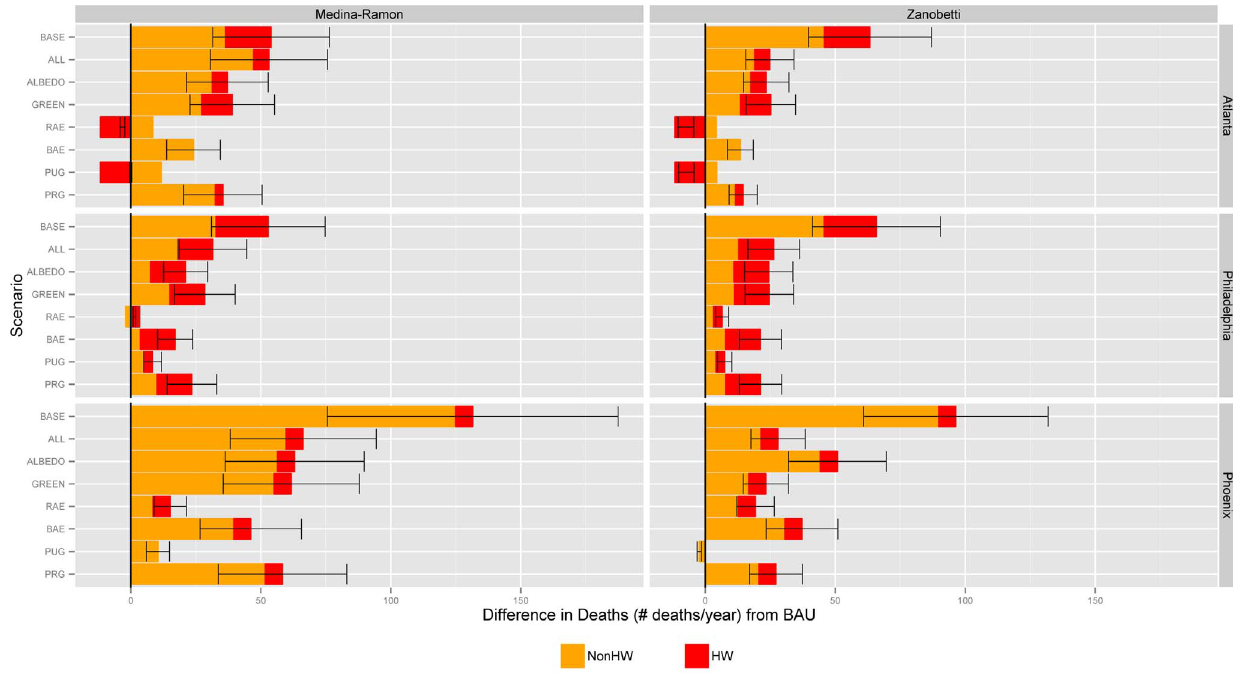
Figure 4. Difference in mortality relative to BAU by heat management scenario, HRF, and MSA. Bars report estimated difference in mortality relative to BAU in response to either the Medina-Ramon minimum temperature (minT) or Zanobetti average apparent temperature (avgapT) HRFs (orange shading) combined with the Anderson average temperature (avgT) HRF for heat wave conditions (red shading). Positive results denote a reduction in mortality relative to the BAU scenario; negative results denote an increase in mortality relative to the BAU scenario. Error bars report 95% confidence intervals.